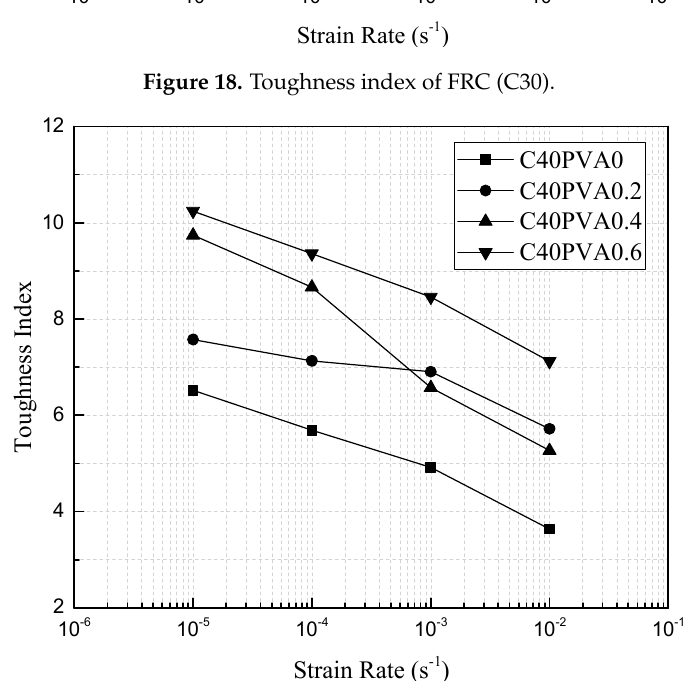
Figure 19. Toughness index of FRC (C40).